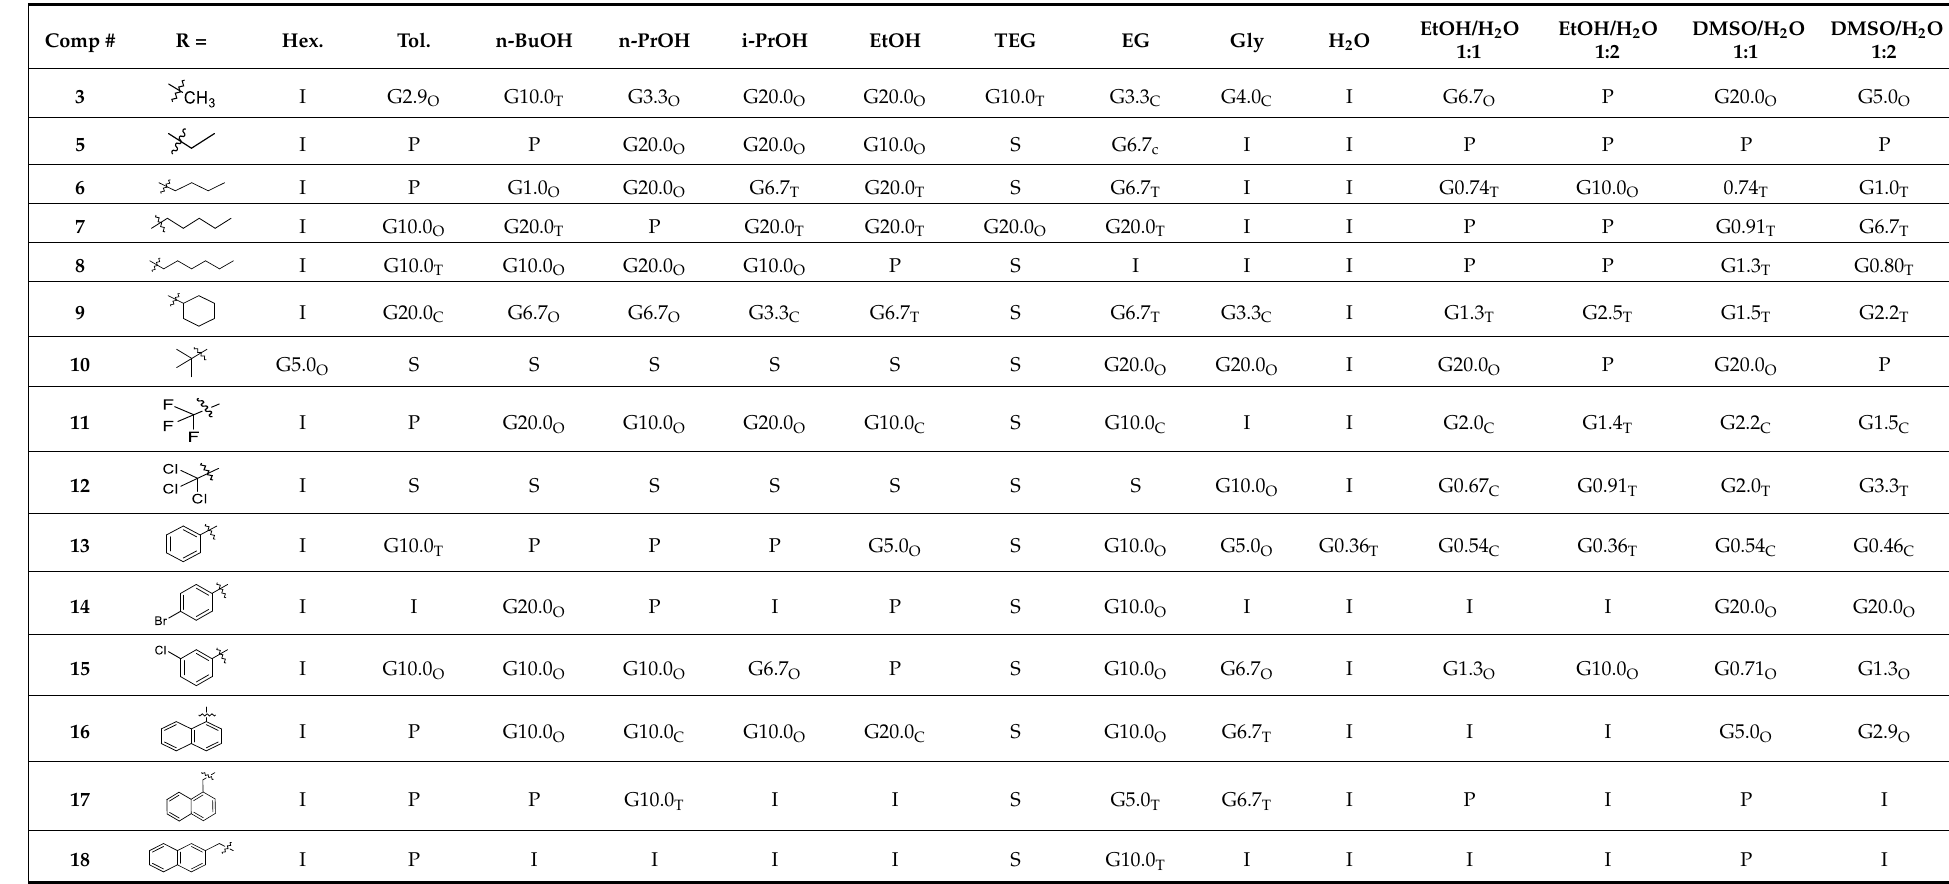
Table 1. Gelation properties of the amides 3 – 18 .